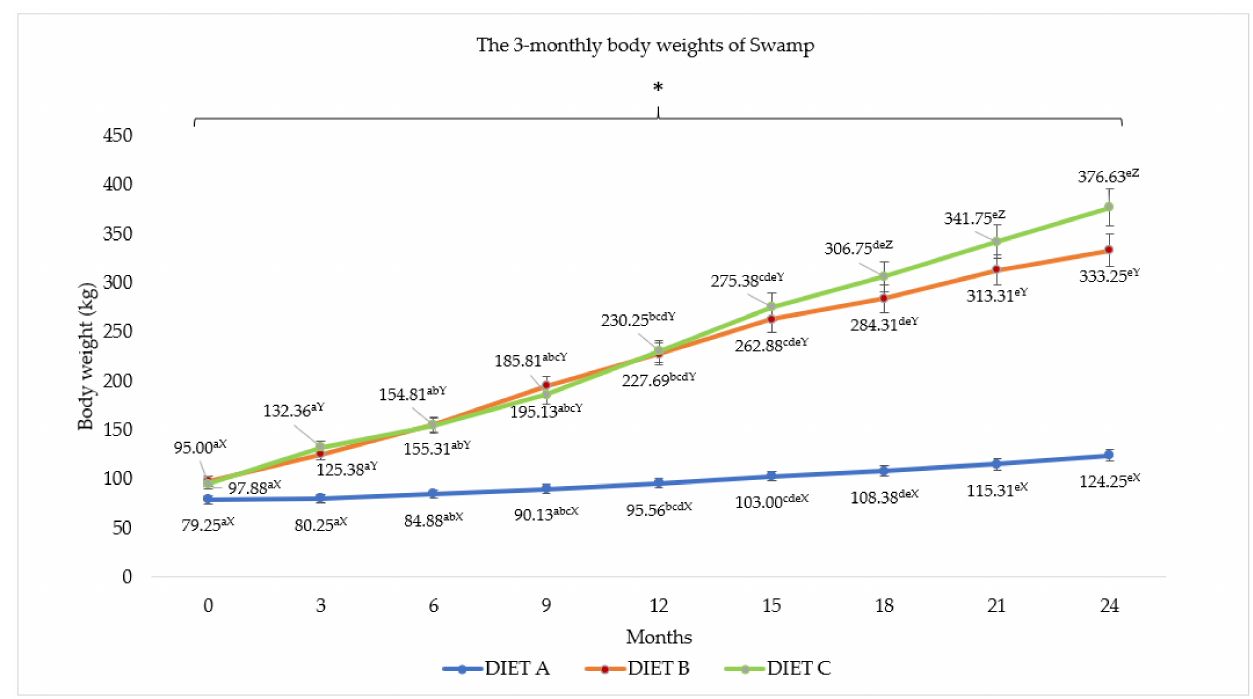
Figure 4. The three-monthly body weight (Mean ± SEM) of Swamp. Diet A (control)—(100% Brachiaria decumbens) ; Diet B—(70% Brachiaria decumbens + 30% concentrate); Diet C—(70% Brachiaria decumbens + 26% concentrate + 4% bypass fat); the values are presented as mean; a,b,c,d,e different superscripts indicate significant difference of three-monthly bodyweight of Swamp buffalo for each Diet A, B, and C at p < 0.05; X,Y,Z different superscripts indicate significant difference between Diet A, B, and C for each three month interval of feeding at p < 0.05; * indicating significant ( p < 0.05) difference comparing body weight and month.